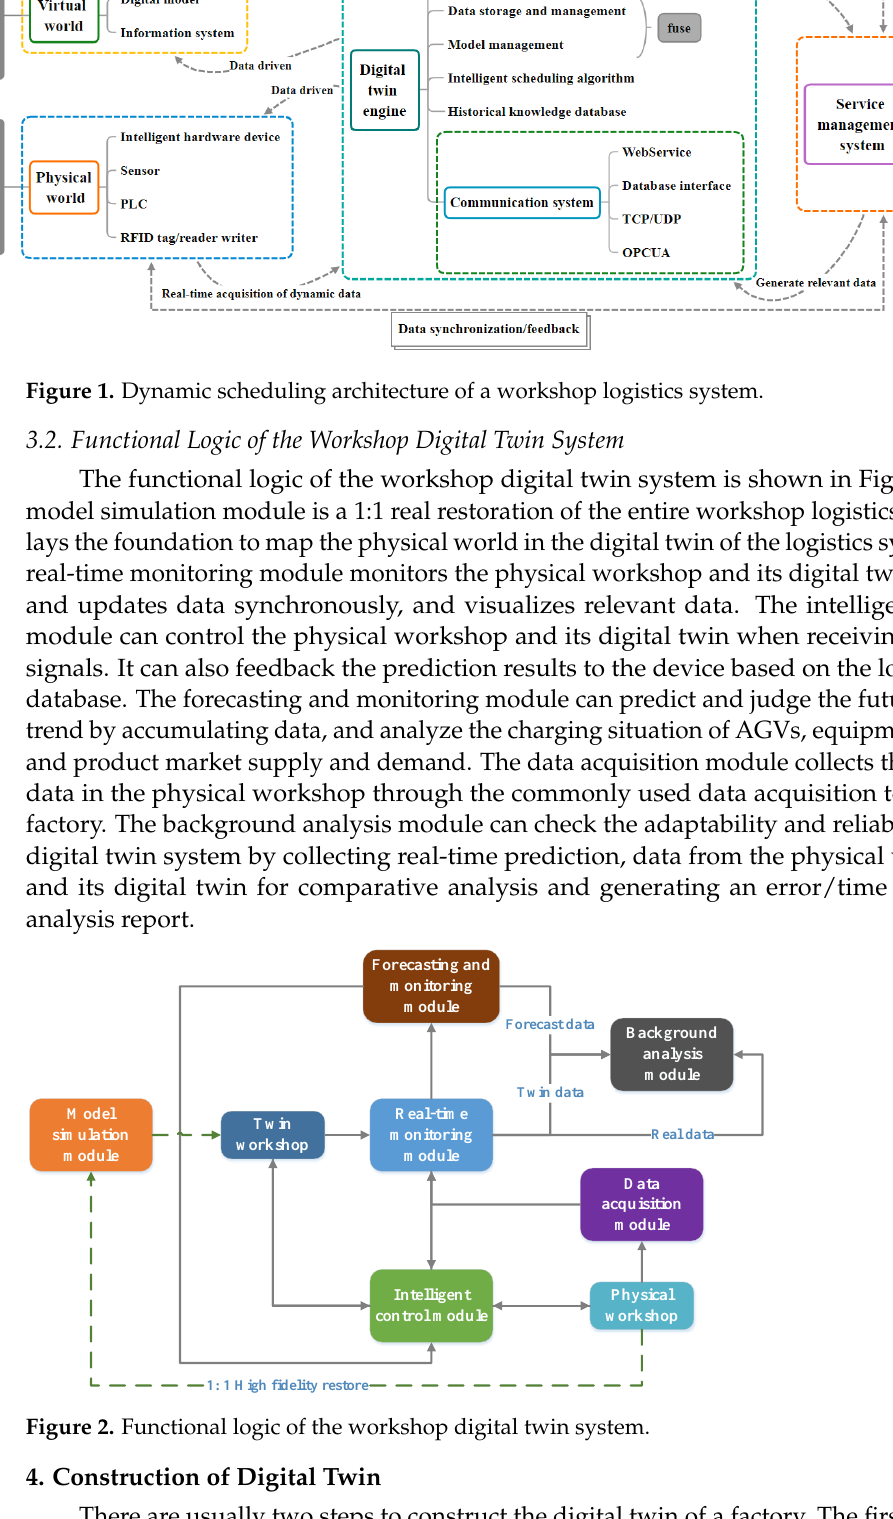
Figure 2. F unctional logic of the workshop digital twin system .